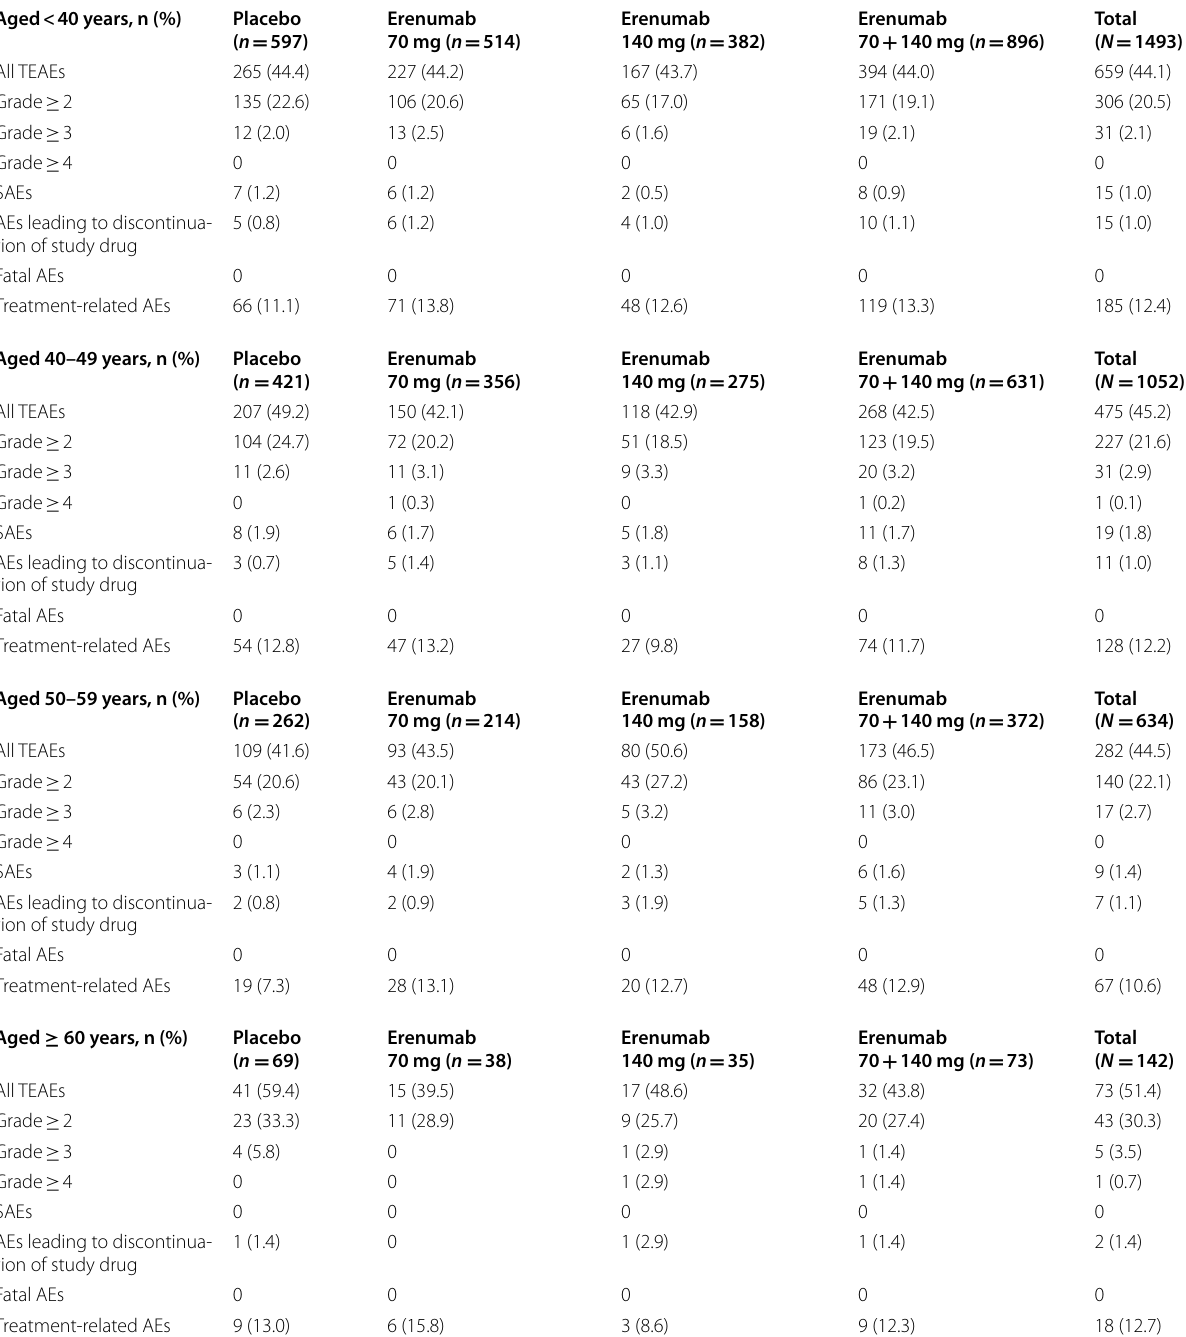
Table 2 Summary of TEAEs by age groups (safety analysis set, double-blind treatment